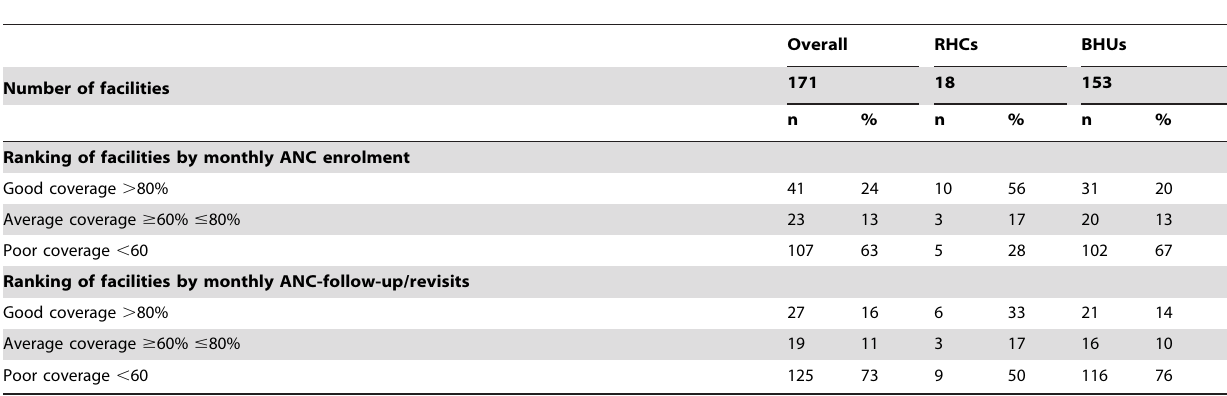
Table 1. Ranking of health facility by ANC-enrolment and follow-up visits in the catchment areas.